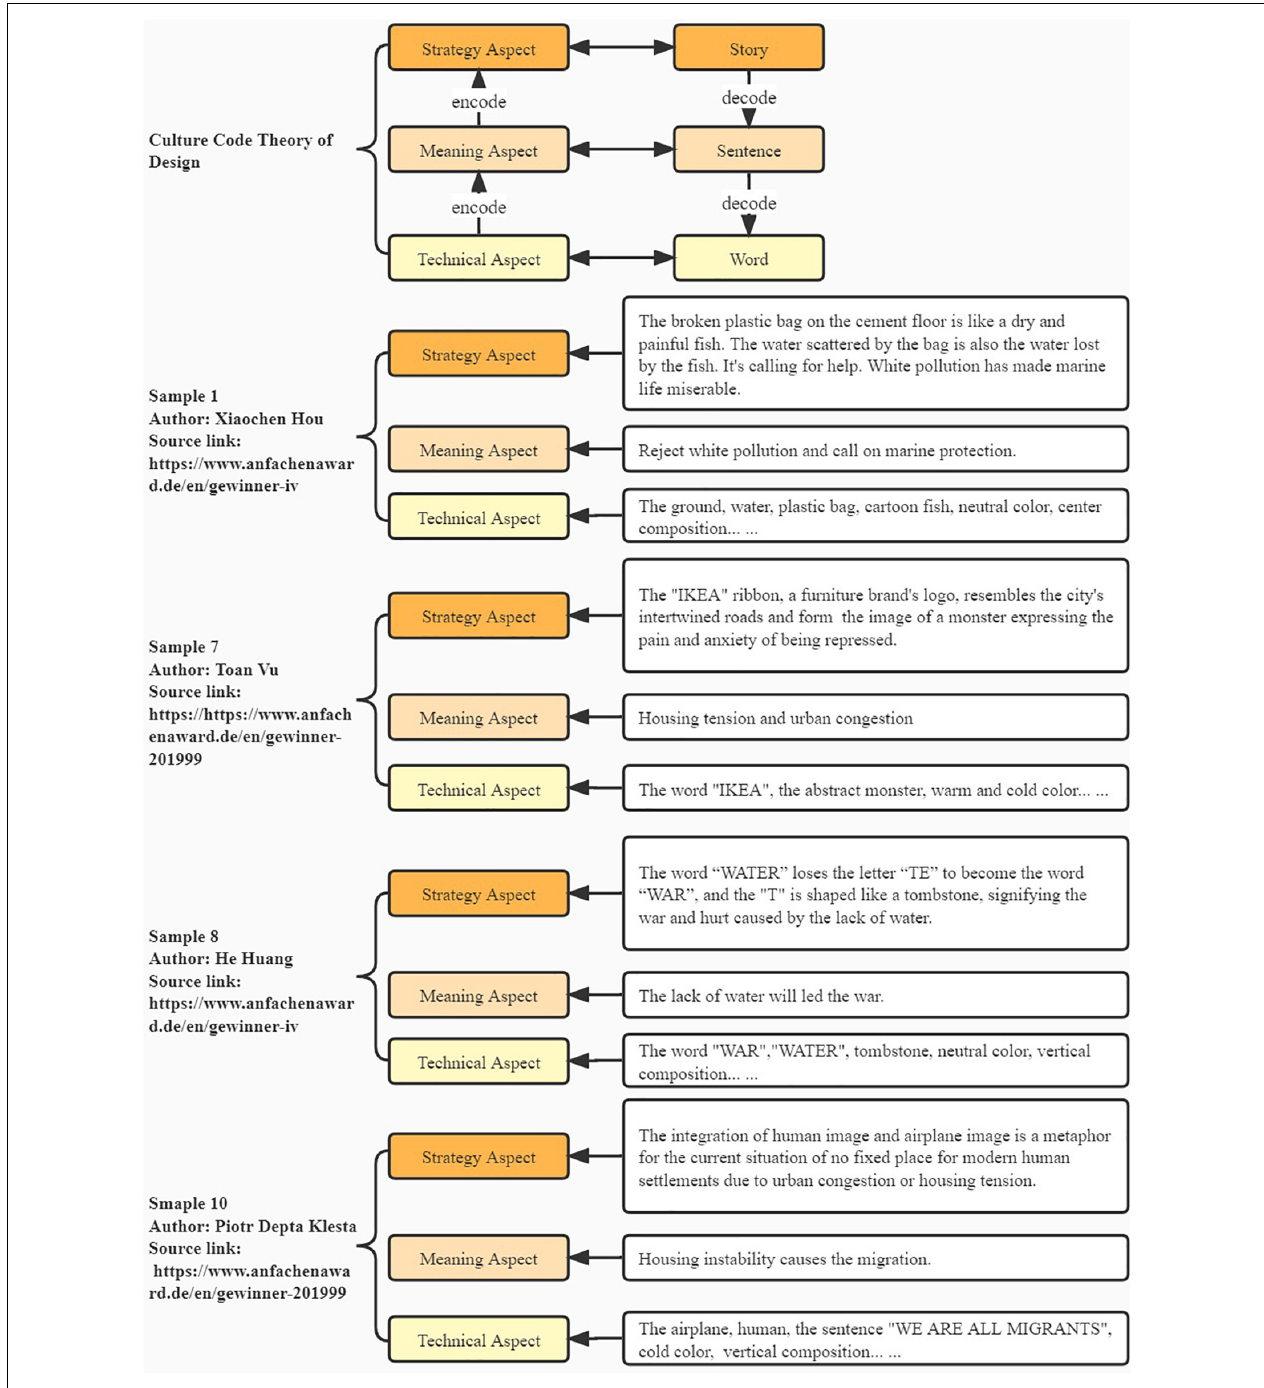
FIGURE 1 | Culture code theory of design. (Poster source: